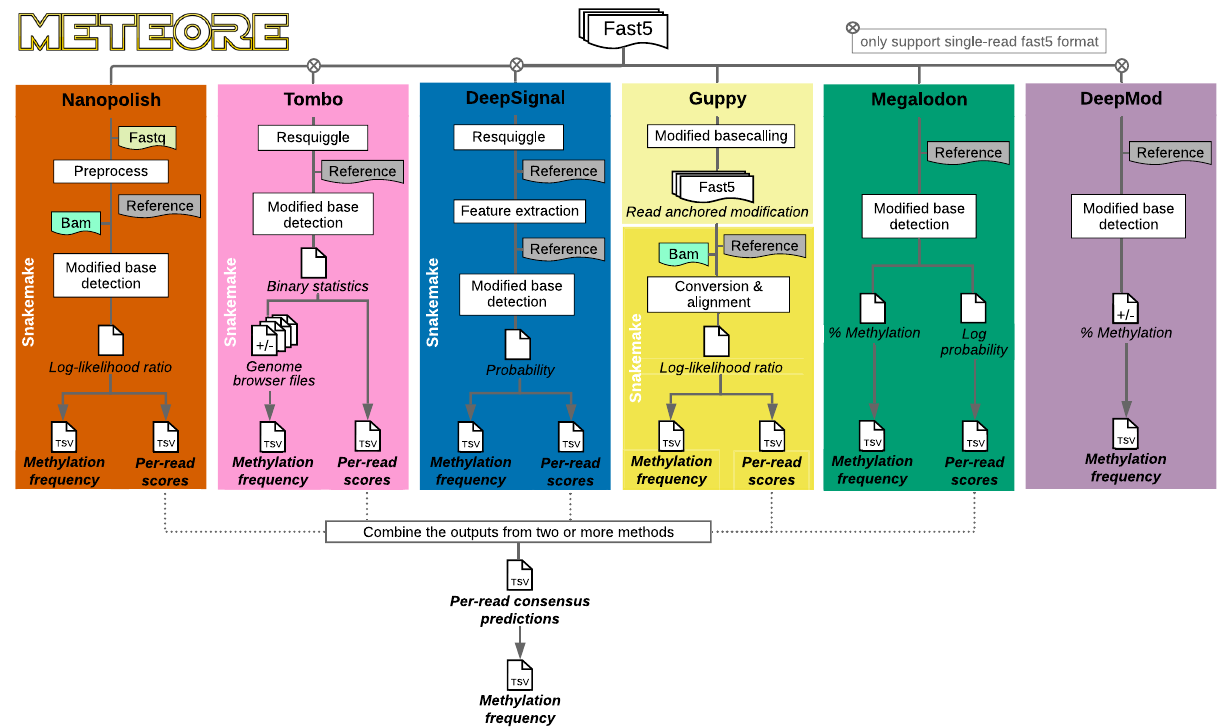
Fig. 1 Analysis pipeline for 5mC detection at CpG sites from nanopore sequencing. The diagram describes the approach used to test the tools Nanopolish, Tombo, DeepSignal, Megalodon, Guppy, and DeepMod. Snakemake pipelines and command lines used are available at https://github.com/ comprna/METEORE 11 . A Snakemake pipeline was not developed for Megalodon and DeepMod as they can be run with a single command. Excluding DeepMod, all tools produce predictions per individual read and per CG site. In addition, all tools predict the methylation frequency at each genome site from fast5 input fi les. Methods that currently only accept single-read fast5 format are